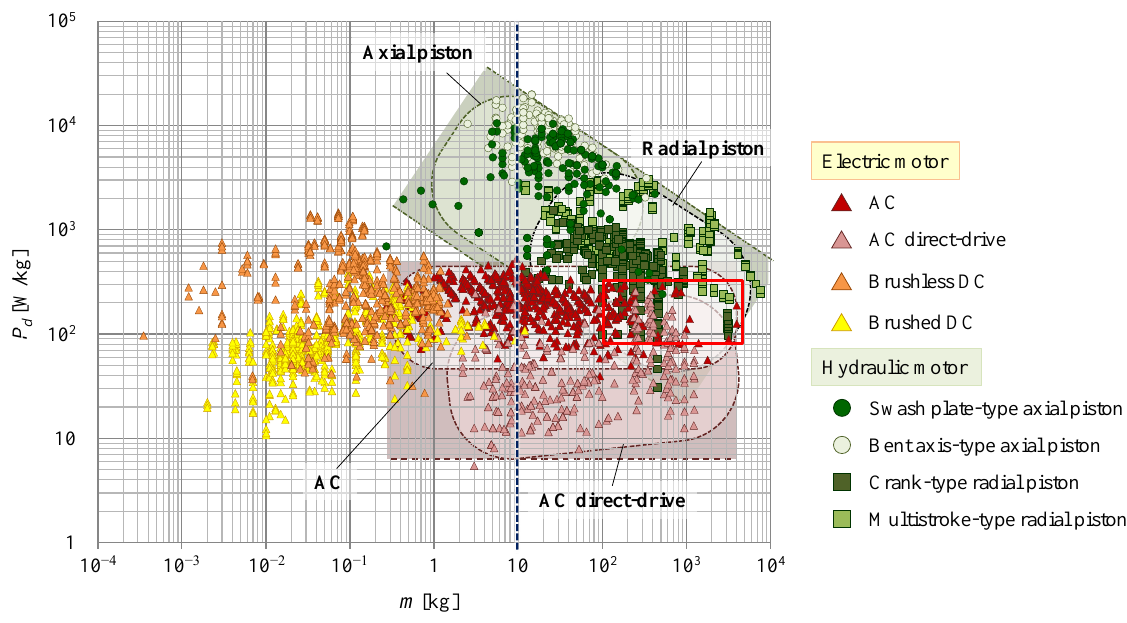
( a ) ( b ) Figure 12. Correlation between rated rotating speed and power density: ( a ) all plots ; ( b ) data in the range surrounded by the red square in Figure 11. 5.4. Power Rate and Power Rate Density Figure 13 shows the relationship between motor weight m and power rate Q calcu- lated by Equation (2). The power rate of hydraulic motors is larger than that of electric